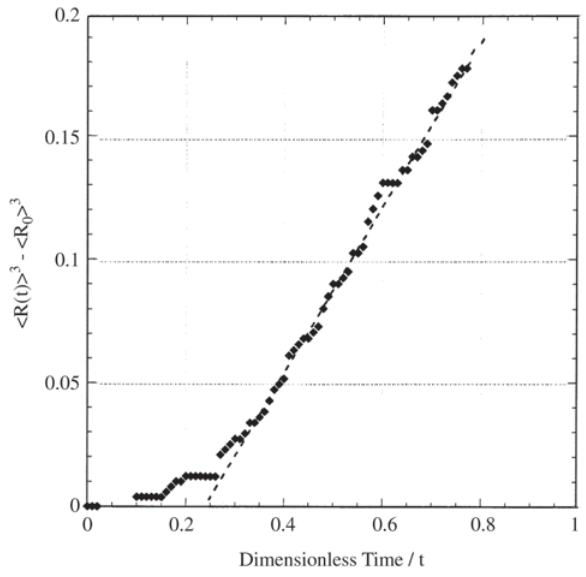
Figure 3. Average of the radius of the particle population cubed, versus time. The predicted linearity of <R> 3 against time develops only after the PSD develops its affine form. Before becoming aff- ine, or “self-similar,” the PSD evolves through the transient evolu- tion of the microstructure’s dispersoid population. Dashed line provided only as a guide to judge the achievement of the predicted linear